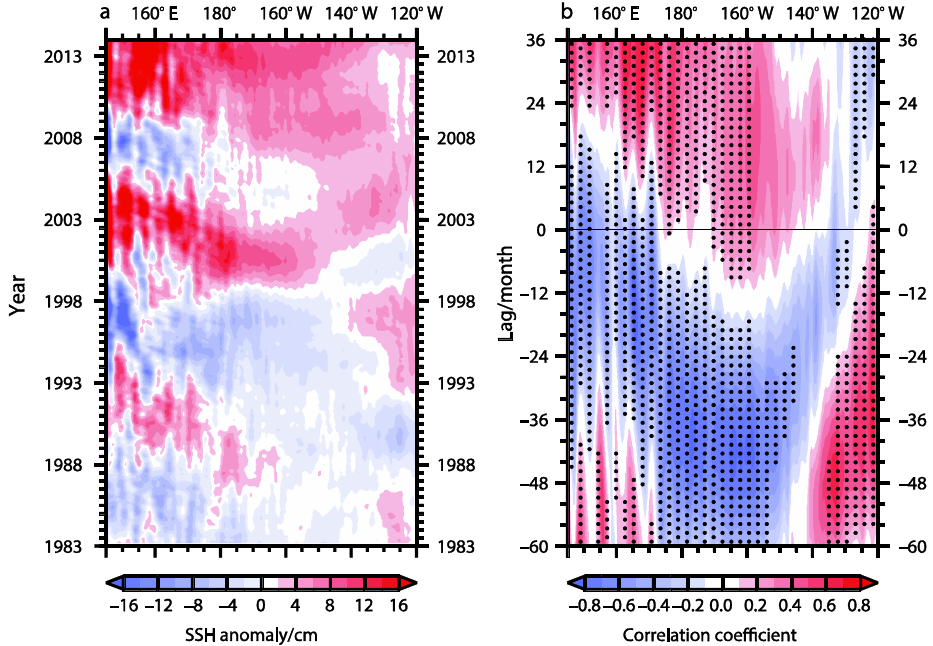
Figure 3. ( a ) Hovmöller plot of the 37-month running mean SSH anomalies averaged over the 33°– 35° N band. These SSH anomaly data were merged from the AVISO satellite data for 1993–2015 and the SODA reanalysis data for 1981–1992. ( b ) Lag–longitude correlation diagram of the 37-month running mean EAI with the SSH anomalies in ( a ). Positive lags mean that the EAI leads the SSH anomalies. The stippled areas indicate statistical significance above the 95% confidence level.